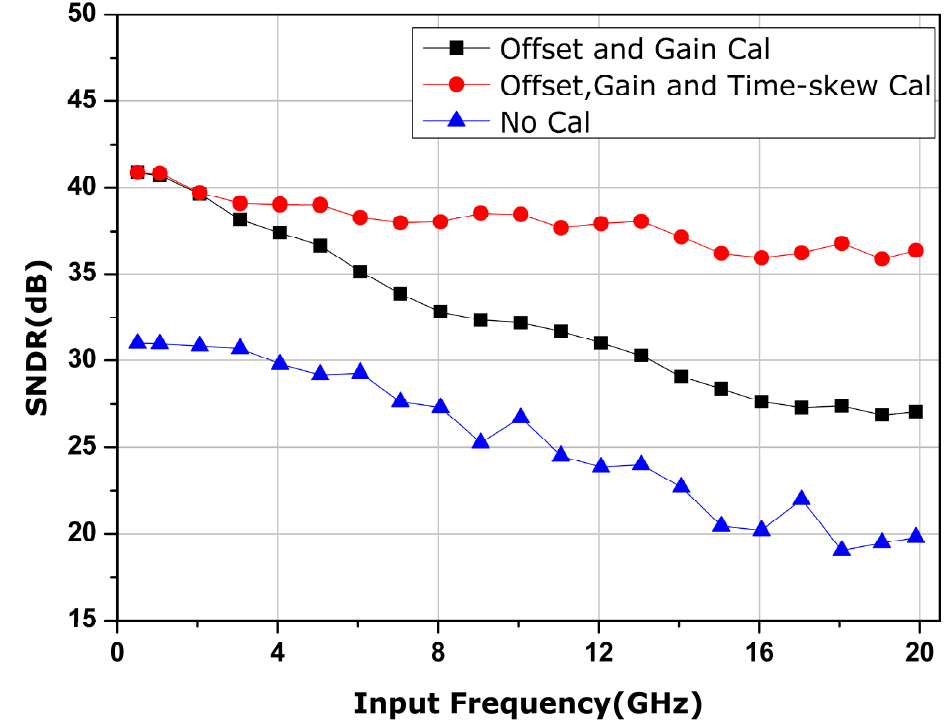
Figure 15. Measured SNDR versus input frequency at a 56 GS/s sampling rate. Table 1. Performance summary and comparison.